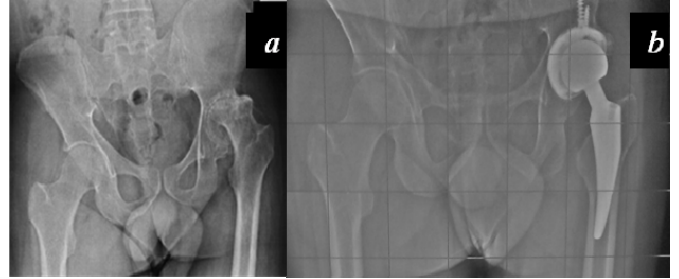
Figure 4. ( a ) Preoperative x ‐ rays of the left hip of a 33 ‐ year ‐ old patient affected by severe haemophilia A; ( b ) X ‐ rays 3 years after surgery: cementless short stem, acetabular cup fixed with two supplementary screws and COP coupling.